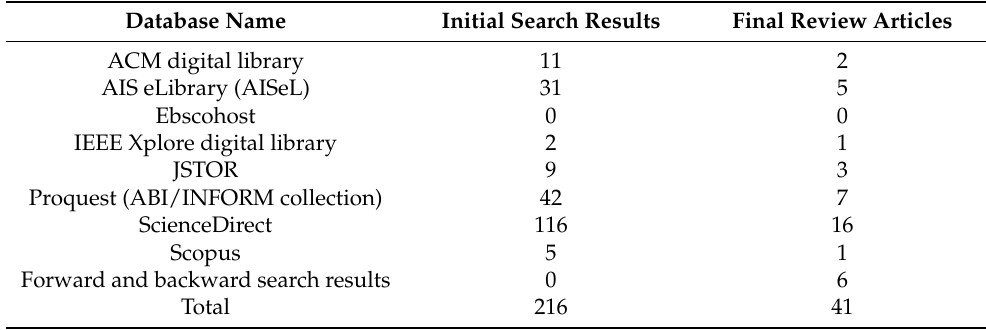
Table 2. An overview of the initial search results and the articles selected for review after filtering, based on the inclusion and exclusion